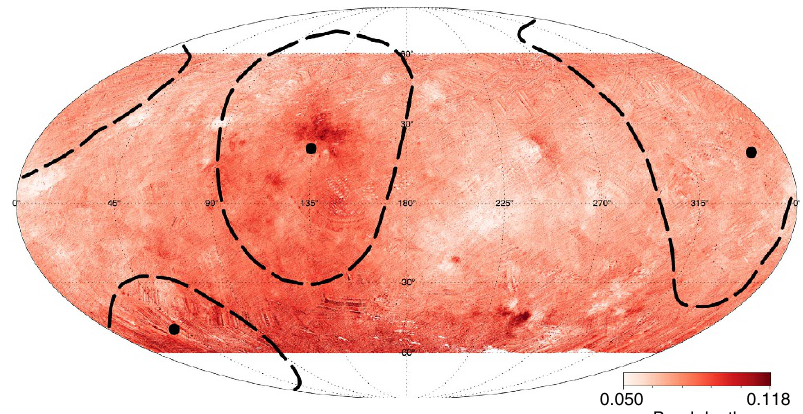
Figure 10 | Global map of the ammoniated phyllosilicates absorption band. The colour shows the strength of the ammoniated phyllosilicates absorption band at 3.1 micron; dark colours indicate deeper band. Dashed lines indicate the boundaries of the three planitiae (see Fig. 7). The map is a Mollweide projection in the latitude range 60 (cid:2) S–60 (cid:2)